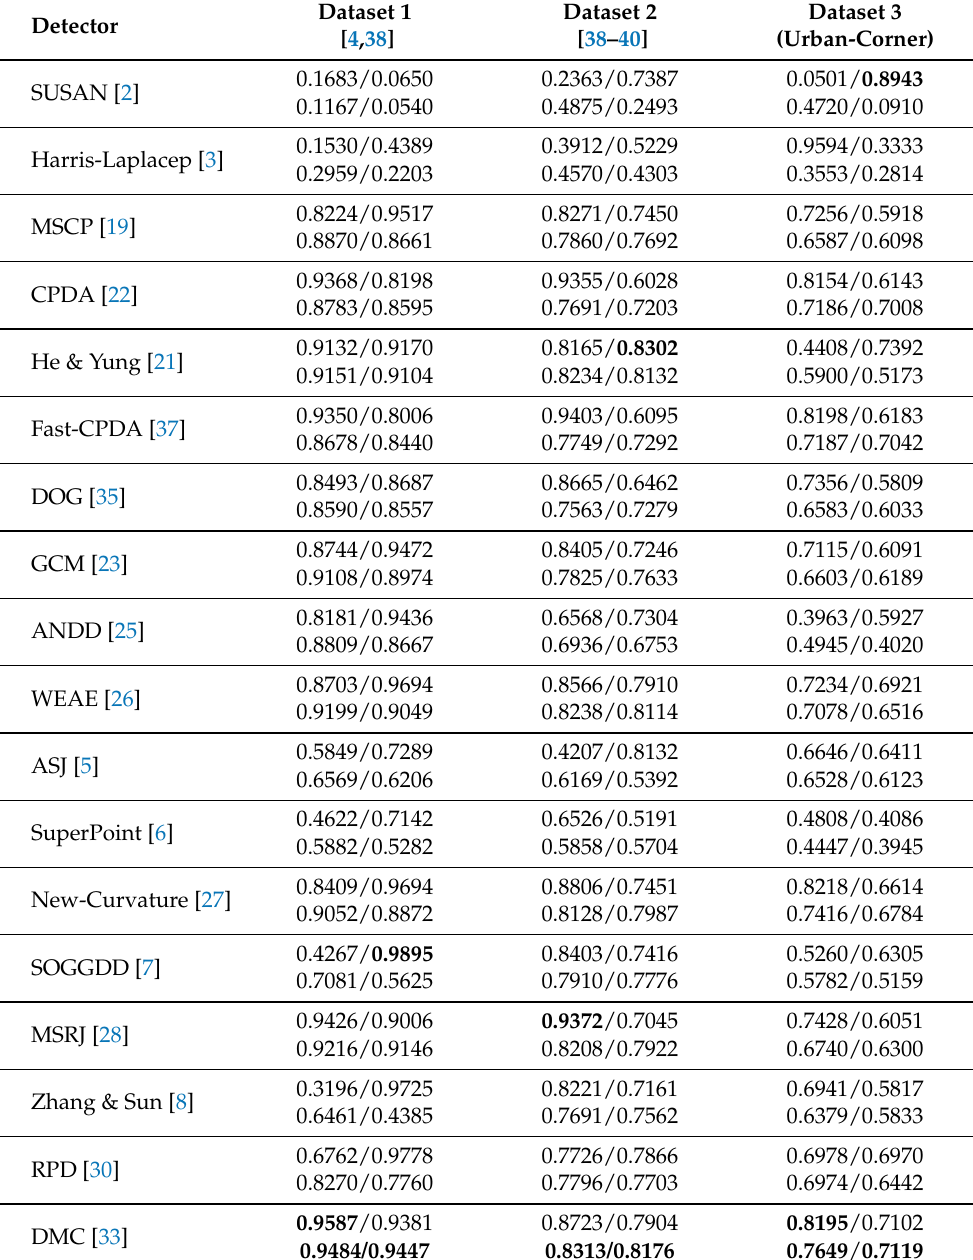
Table 1. Evaluation results in terms of precision/recall (first entry) and APR/F score (second entry). The best performance with respect to each used metric achieved on each image dataset is highlighted in